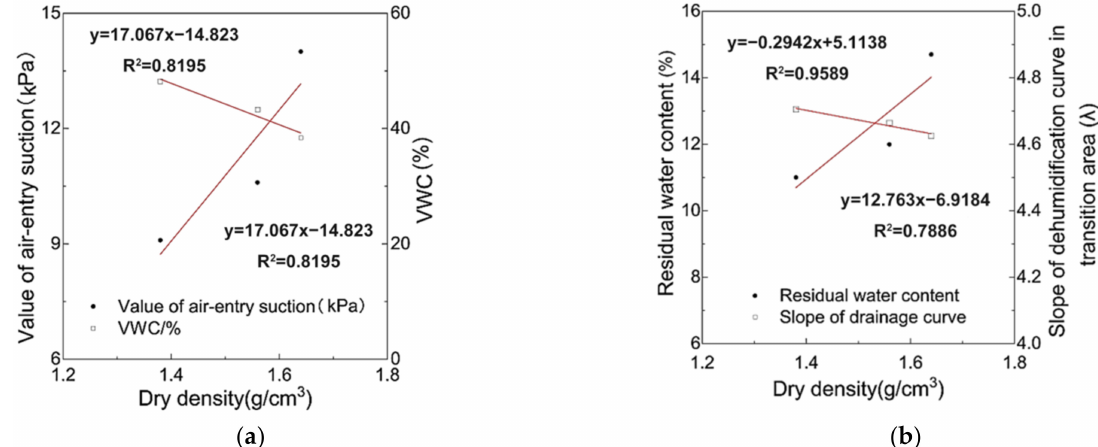
Figure 9. ( a ) Correlation between λ and sand-sized content; ( b ) correlation between λ and silt-sized content; ( c ) correlation between drying-cycle slope ( λ ) and clay-sized content.